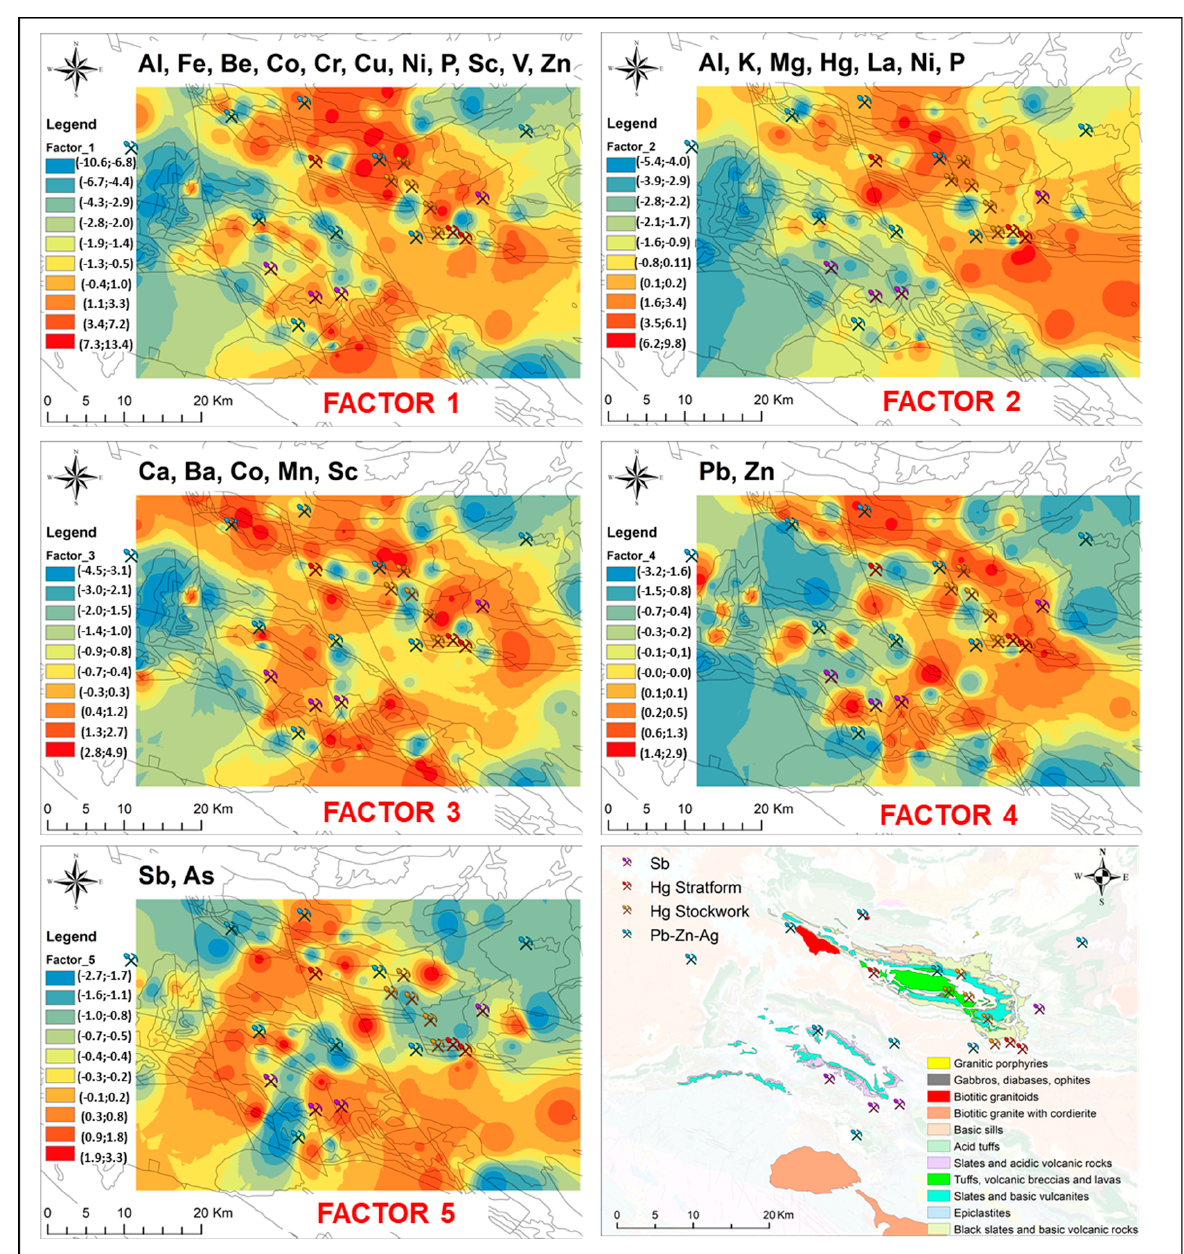
Figure 6. Spatial distribution of factors. A geological scheme is provided as a reference with the main mines indicated, separated by elements or genetic type.